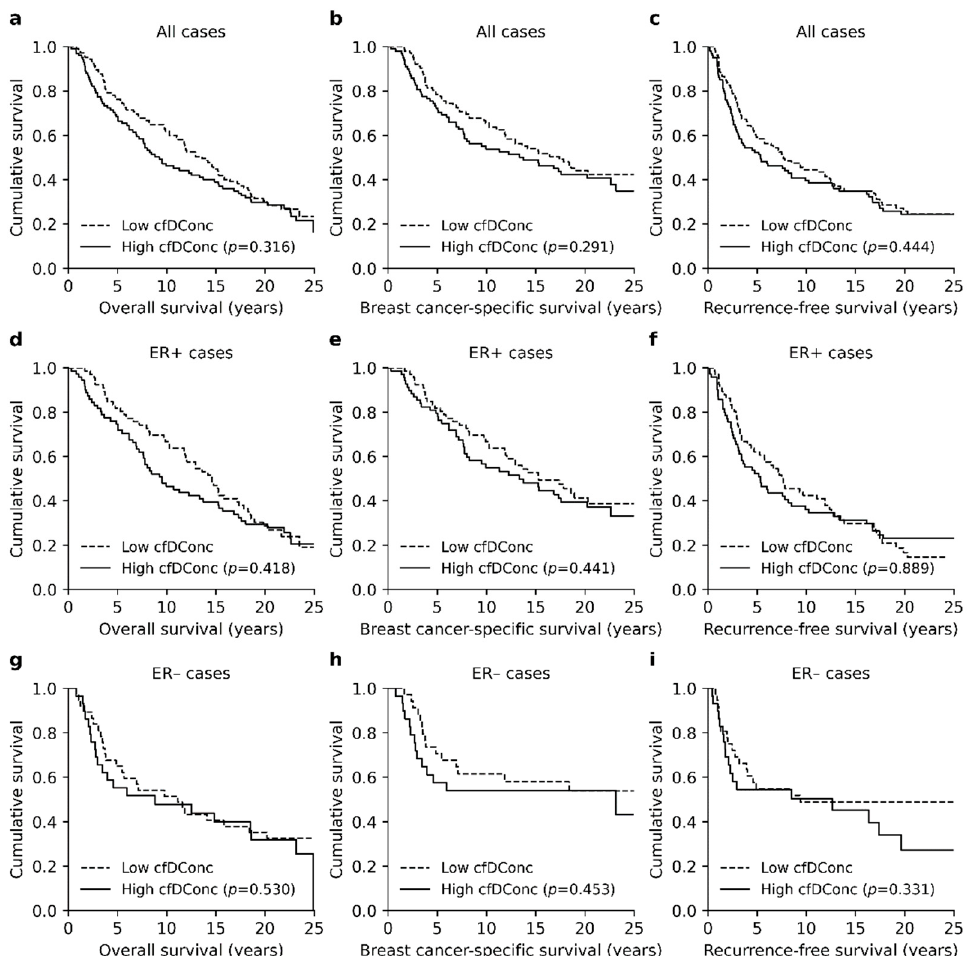
Figure 2. Kaplan–Meier plots representing the association between cfDConc and BC survival. ( a – c ) Patients with high